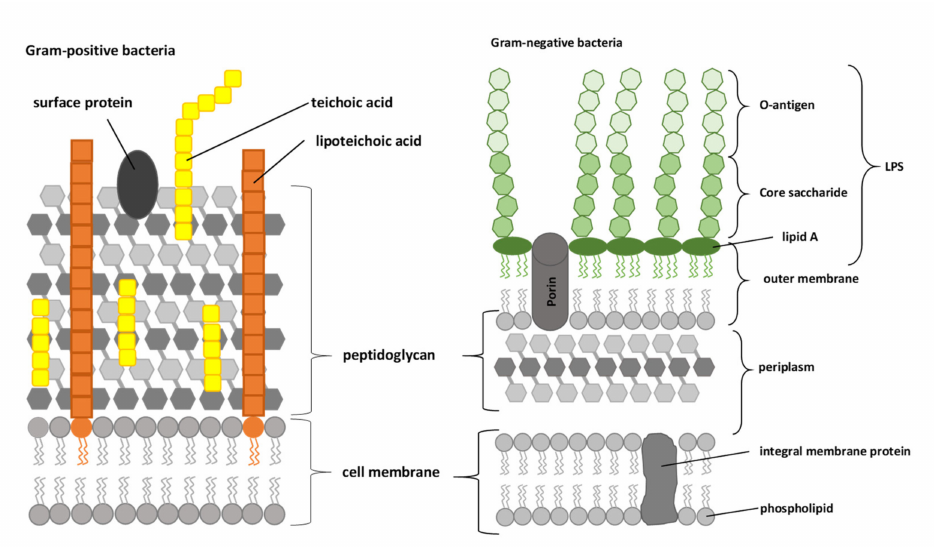
Figure 2. Compositions of the Gram-positive and Gram-negative bacterial cell envelopes. LPS, lipopolysaccharide, composed of O-antigen, core saccharide, and lipid A (adapted from [67]). It has been shown that human lactoferrin can bind to lipid A of LPS, and for this binding, the Arg2–Arg3–Arg4–Arg5 stretch of human lactoferrin is essential [68,69]. The human lactoferrin binding site for LPS is in the N-terminal domain loop region of amino acids 20 to 37, and more specifically, this involves amino acids 28 to 34 (Figure 3A). This loop region is also present in the sequence of the lactoferrin cleavage peptide known as